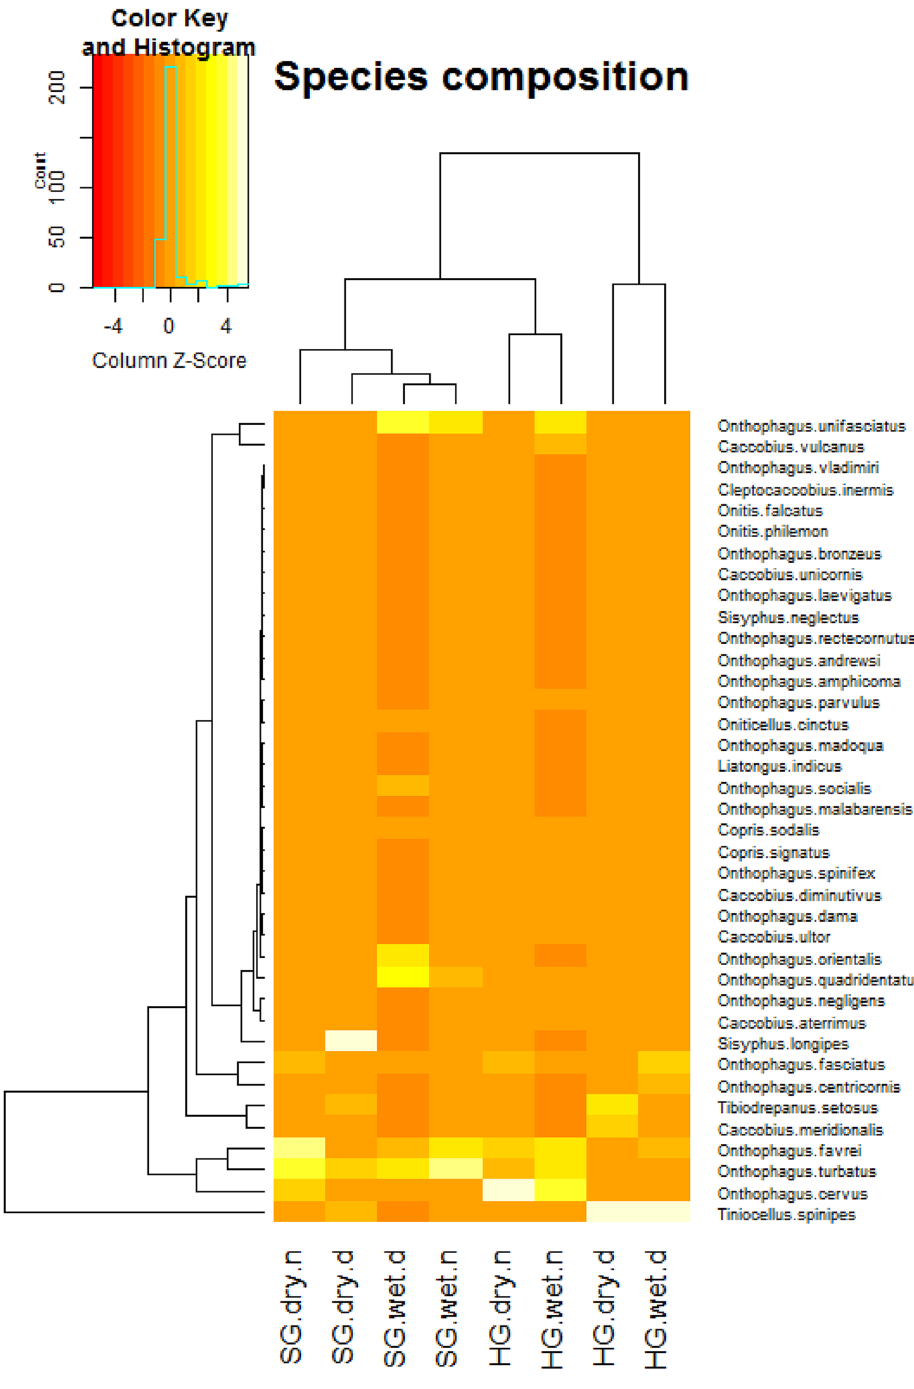
Figure 6. Heat map shows that the diurnal community of open habitat (HG) by any season is distinct from other communities in open (HG) and closed habitats (SG). dry and wet dry season and wet season, d and n diurnal and